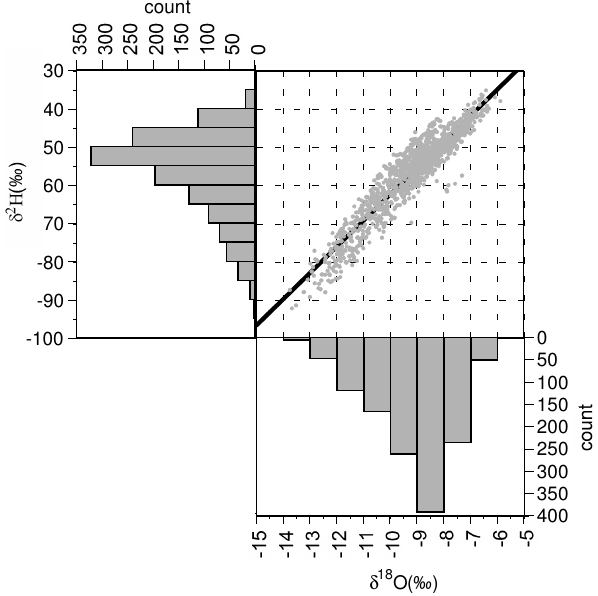
Figure 2. Relationship between δ 18 O and δ 2 H values and their fre- quency distributions in stream